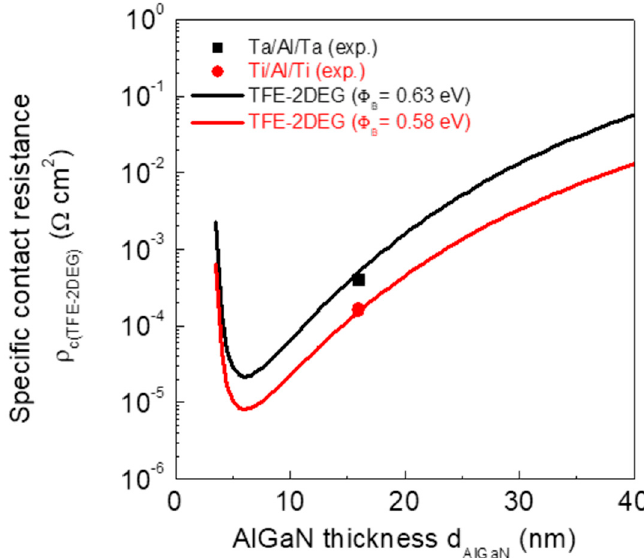
Figure 8. Specific contact resistance ρ C(TFE-2DEG) versus the AlGaN thickness (d AlGaN ) for Ta / Al / Ta and Ti / Al / Ti Ohmic contacts on AlGaN / GaN heterostructures, calculated using the TFE-2DEG model (Al concentration of 26%). The experimental data points are also reported .